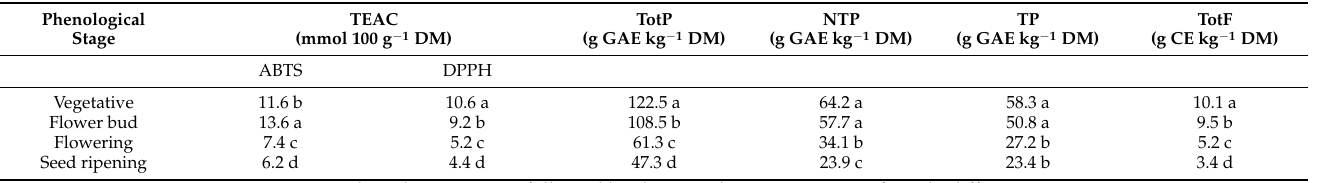
Table 1. Total antioxidant capacity (TEAC) by ABTS and DPPH methods, total phenolics (TotP), non- tannic phenolics (NTP), tannic phenolics (TP), and total flavonoids (TotF) in the examined Trifolium subterraneum